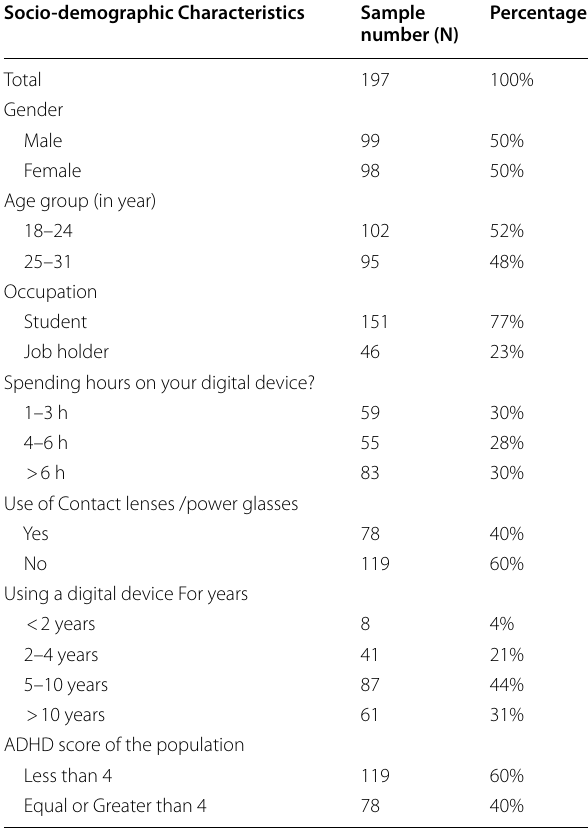
Table 1 Socio-demographic characteristics and percentage